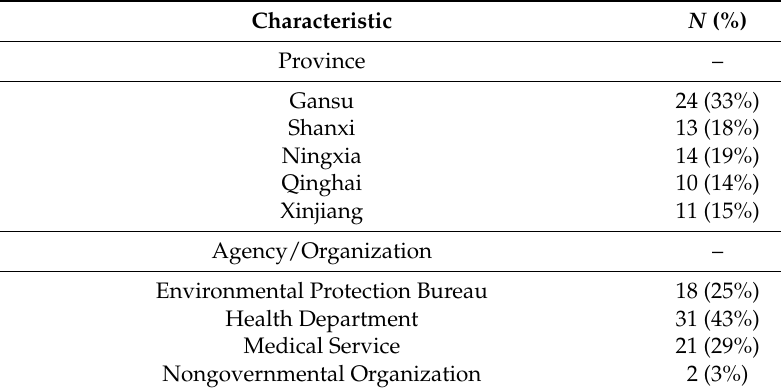
Table 2. Policy interview